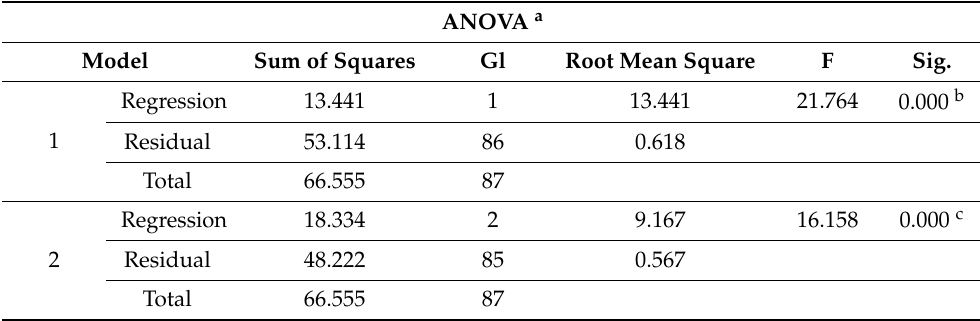
Table 5. ANOVA between regression and residuals of the multiple linear regression analysis. Source: own elaboration. ANOVA a Model Sum of Squares Gl Root Mean Square F Sig. Regression 13.441 1 Residual